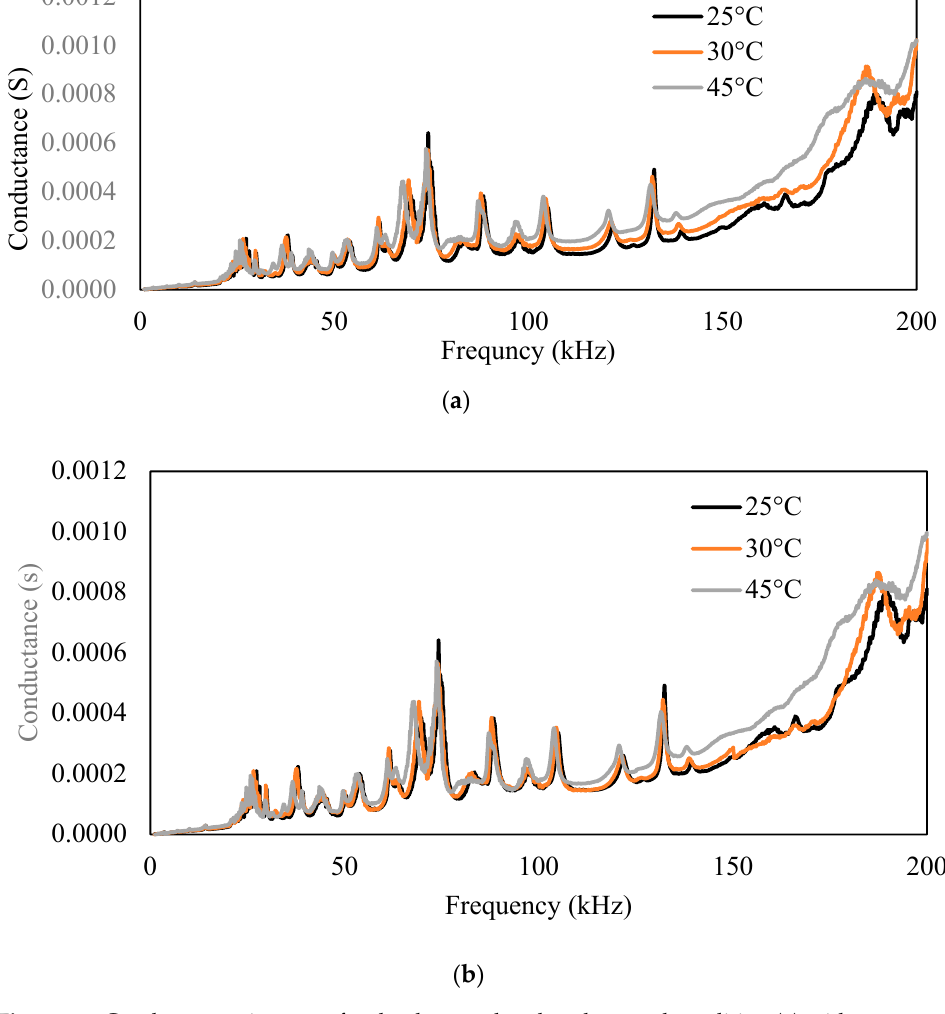
Figure 17. Conductance signature for the damaged and undamaged condition ( a ) with temperature effect and ( b ) after compensation of temperature effect.